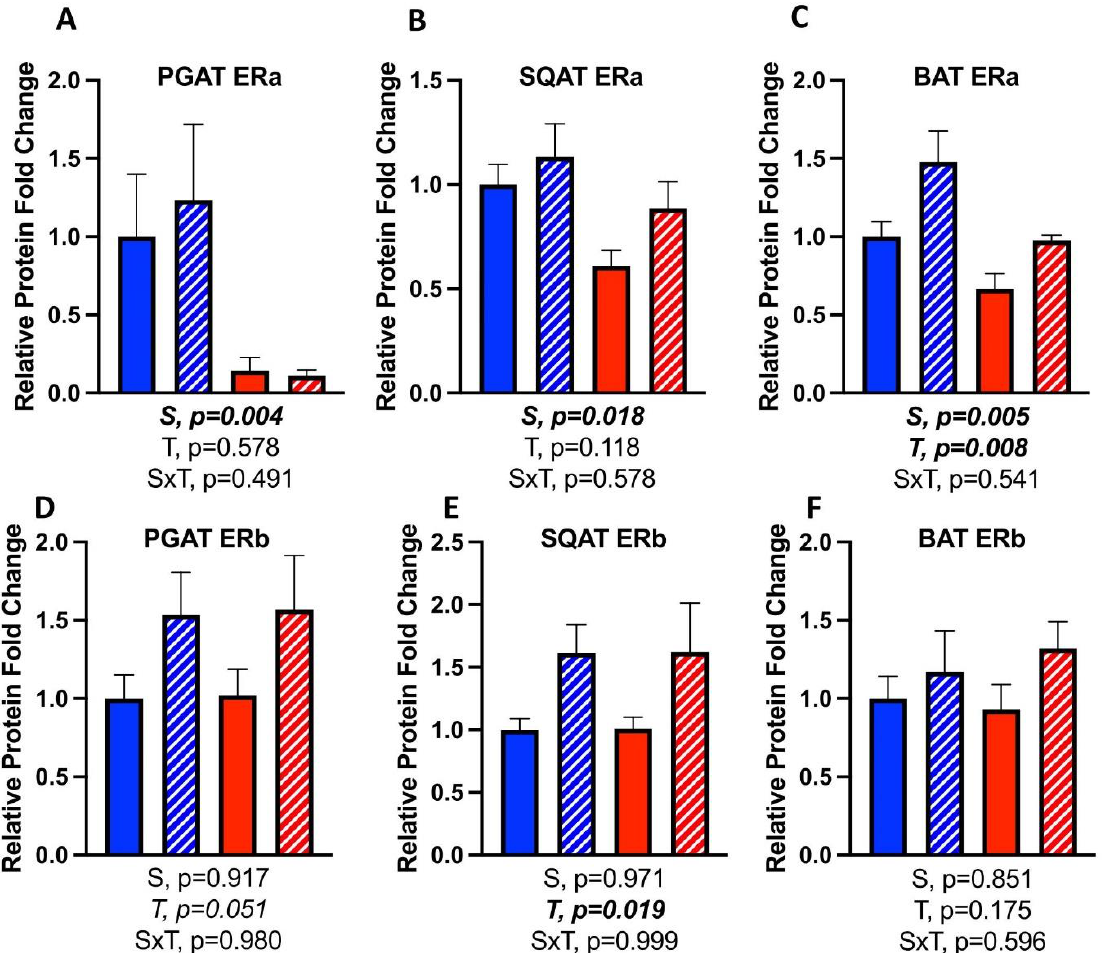
Figure 10. Male (M) and female (F) C57BL/6J mice, all on HFD, were treated for 2 weeks with daily CL injections (1 μg/g body weight) or CTRL (saline). Perigonadal (PGAT), subcutaneous (SQAT) and brown (BAT) adipose tissue depots were collected and the protein expression of estrogen receptor alpha (ERa) and estrogen receptor beta (ERb) was measured via Western blotting. ( A ) PGAT ERa; ( B ) SQAT ERa; ( C ) BAT ERa; ( D ) PGAT ERb; ( E ) SQAT ERb; ( F ) BAT ERb. Representative Western blot images are provided as a Supplementary Figure. Blot intensity was expressed relative to beta actin. All data are presented as mean ± SEM. N = 7–9/group. Main effects of sex (S), CL treatment (T) and sex by treatment interactions (S×T) were determined by 2 × 2 ANOVA and are reported below the figure. p -value < 0.05 was accepted as significant.